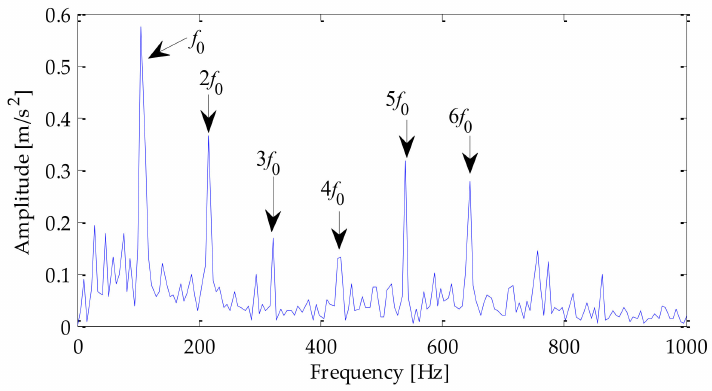
Figure 41. Analysis of signal envelope spectrum after noise reduction based on the proposed method.